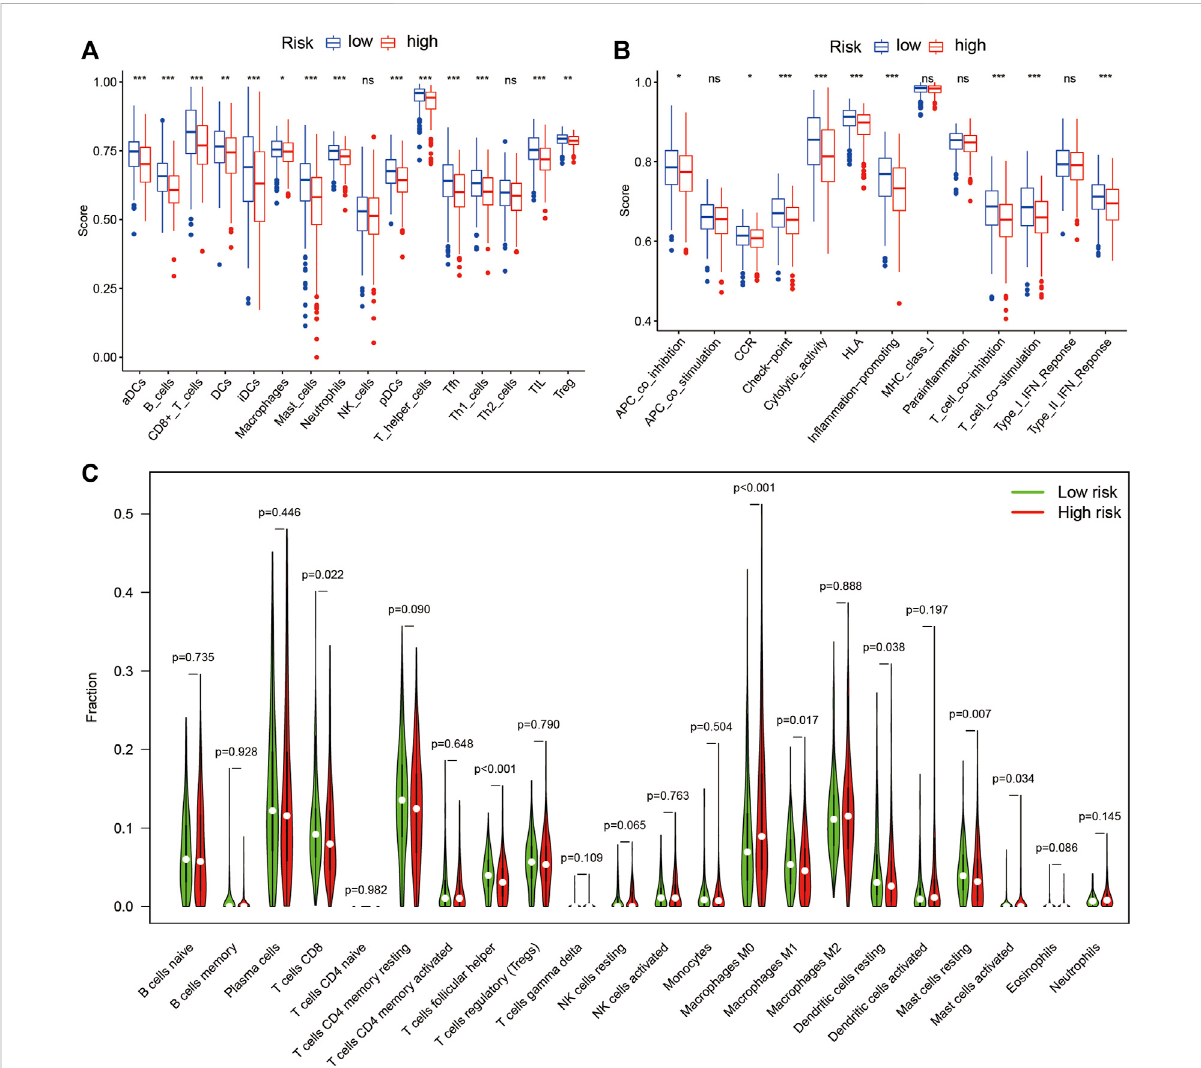
FIGURE 11 Immune cell in fi ltration and immune-related functions in different risk groups. The ssGSEA algorithm was used to compute the score levels of in fi ltrationof16immunecells. (A) and13immune-relatedfunctions. (B) inthehigh-andlow-riskgroups. (C) TheWilcoxonrank-sumtestwasusedto determine differences between the 22 types of immune cells between high- and low-risk groups. SsGSEA, single-sample Gene Set Enrichment Analysis; aDCs, activated dendritic cells; iDCs, immature dendritic cells; NK, natural killer; pDCs, plasmacytoid dendritic cells; Tfh, T follicular helper; Th1, T helper type 1; Th2, T helper type 2; TIL, tumor-in fi ltrating lymphocyte; Treg, T regulatory cell; APC, antigen-presenting cell; CCR, C-C chemokinereceptor;HLA,humanleukocyteantigen;MHC,majorhistocompatibilitycomplex;IFN,interferon;* p < 0.05;** p < 0.01;*** p < 0.001;ns, non-signi fi cant; p < 0.05 indicates statistical signi fi